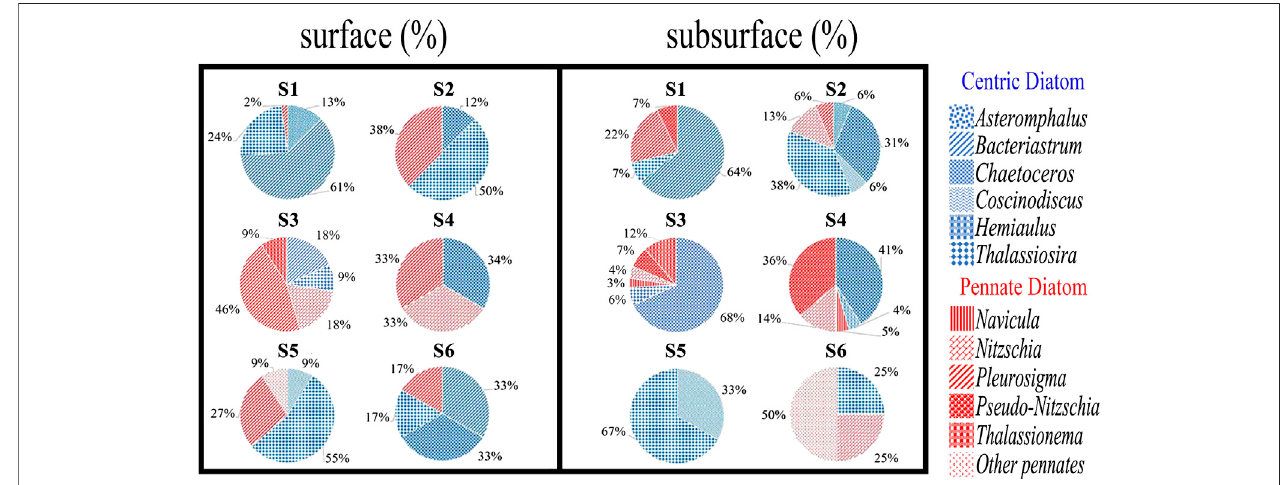
FIGURE 3 | Pie charts showing the relative abundances of centric and pennate diatom cells in surface (5 m) and subsurface (Chl maximum depth) waters.